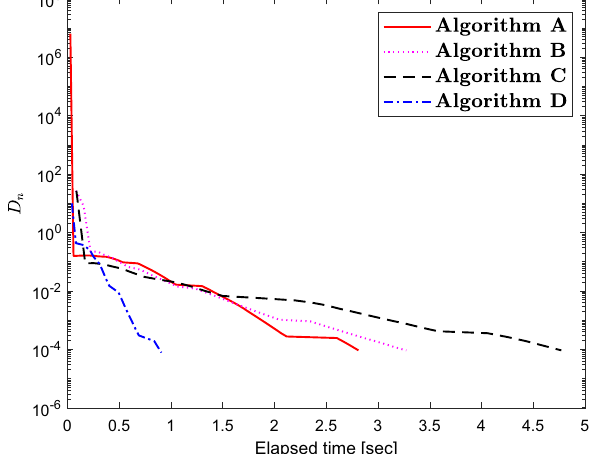
Fig. 7 Numerical illustration of Algorithm 1 with Algorithm 1 in [16] and Algorithm 3.1 in [1] and Algorithm 3.1 in [27] while u 0 = u 1 = ( 1 , 2 ,..., 5000 , 0 , 0 ,...)